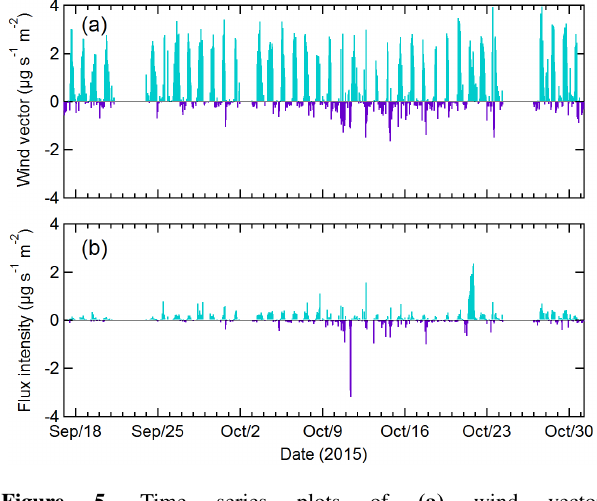
Figure 5. Time series plots of (a) wind vector n P ( = 1 WS j × cos θ j ) and (b) surface transport intensity for n j = 1 refractory black carbon (rBC) based on the hourly averaged data at the Lulang site. Positive values indicate the transport direction of rBC from south to north (i.e., from the Indo-Gangetic Plain and Bangladesh to Lulang) and the negative values represent the transport direction of rBC from north to south (i.e., from the interior of the Tibetan Plateau) to